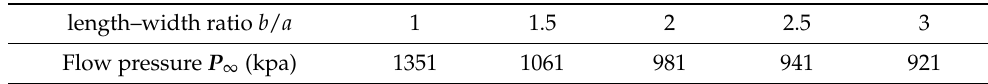
Table 11. Flow pressures with length–width ratio